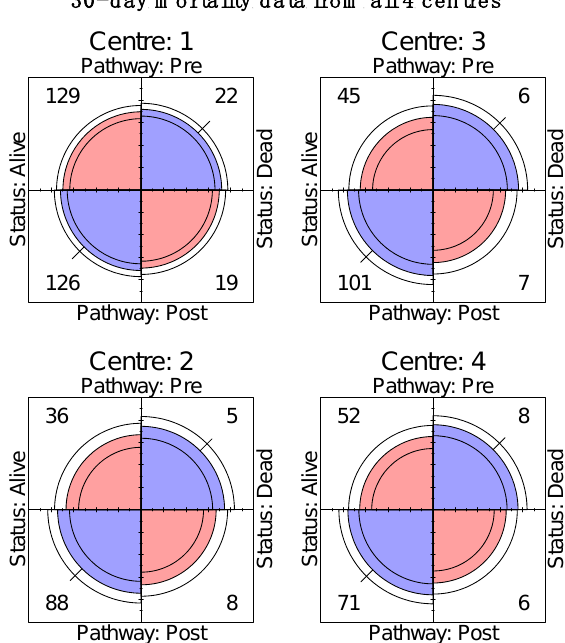
Figure 6. Centre specific 30-day mortality data.